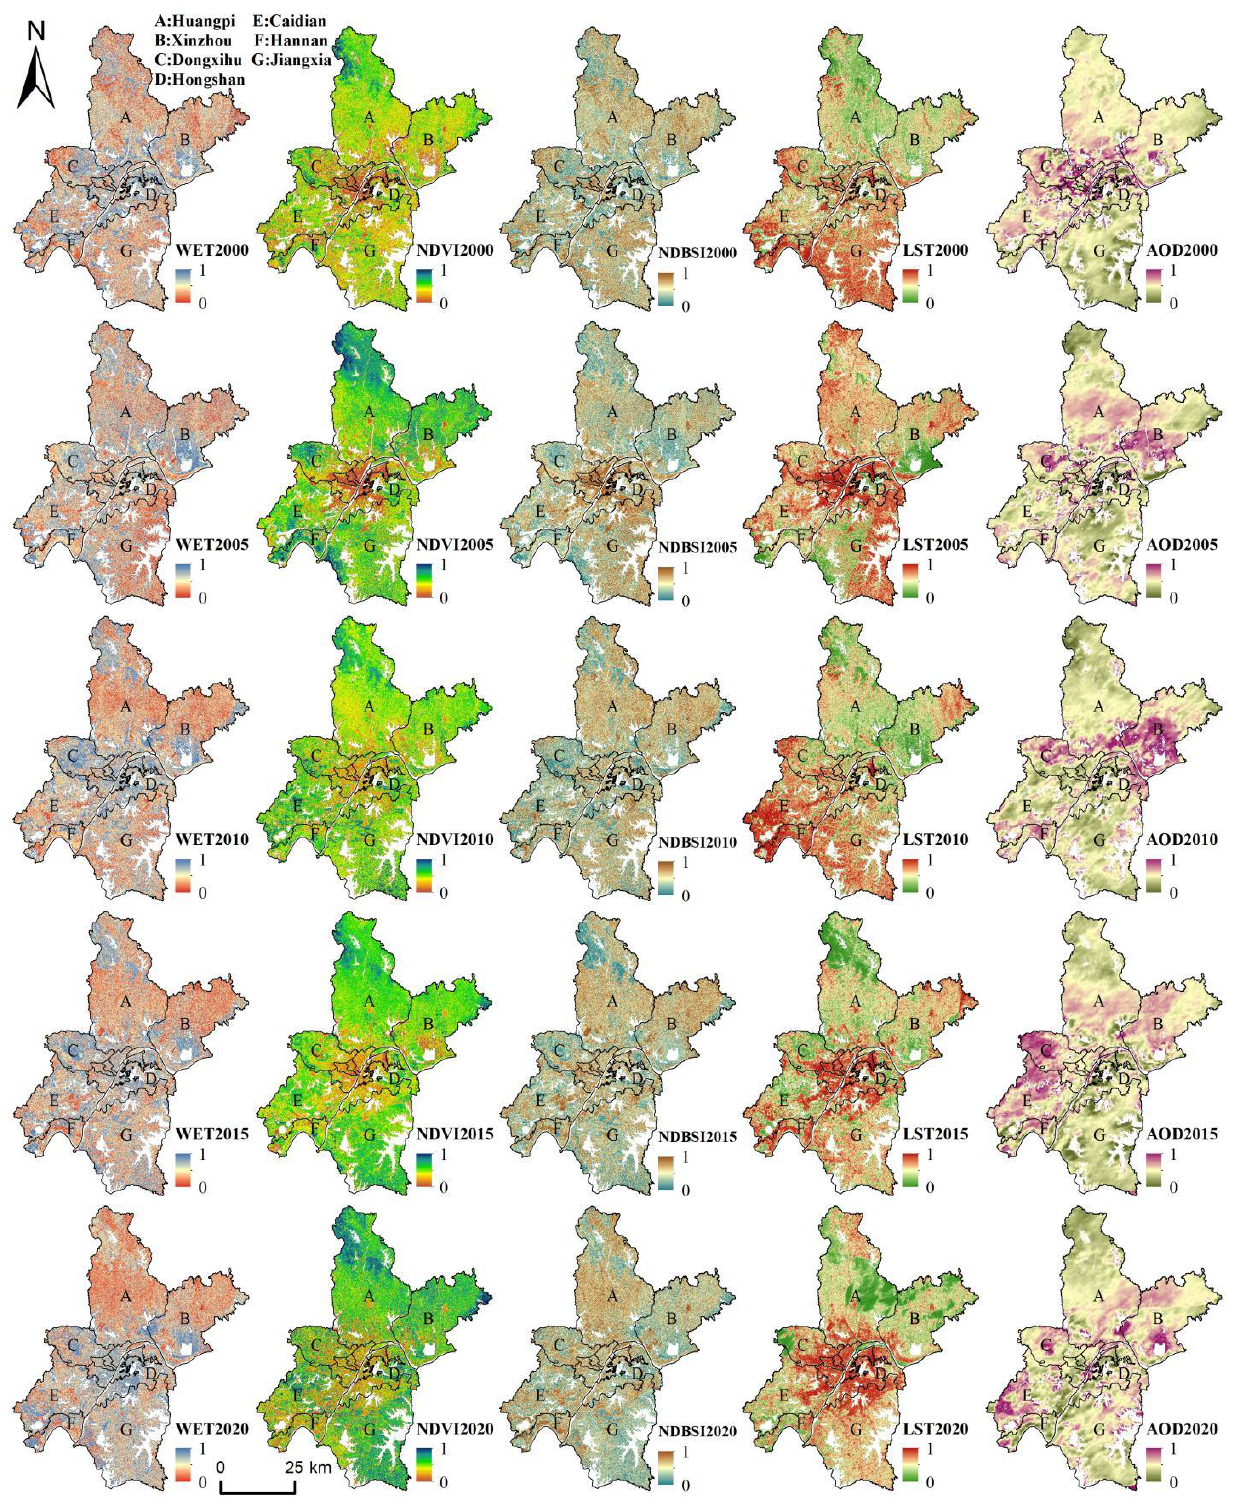
Figure 3. Spatial distribution of the ecological indicators in the land region.